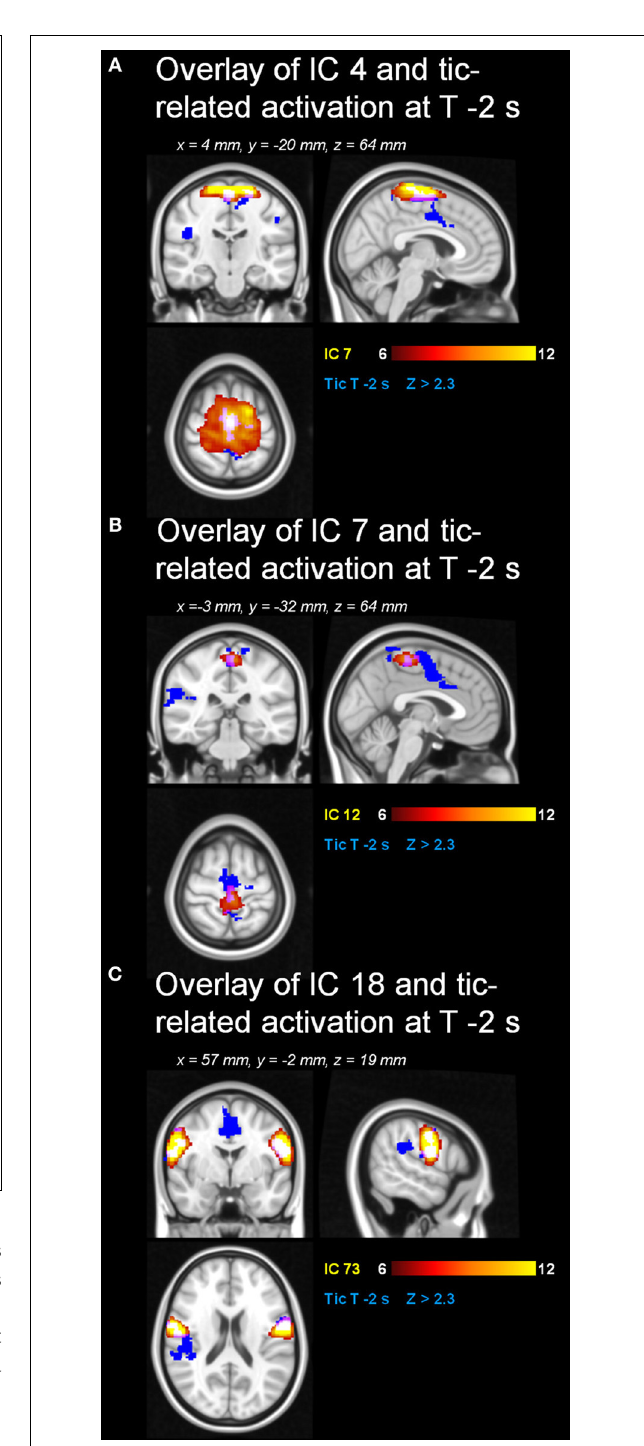
FIGURE 6 | Resting state networks with spatial overlap with tic-related activity. Spatial overlap of the RSNs (A) 4, (B) 7 and (C) 18 with tic-related activity at